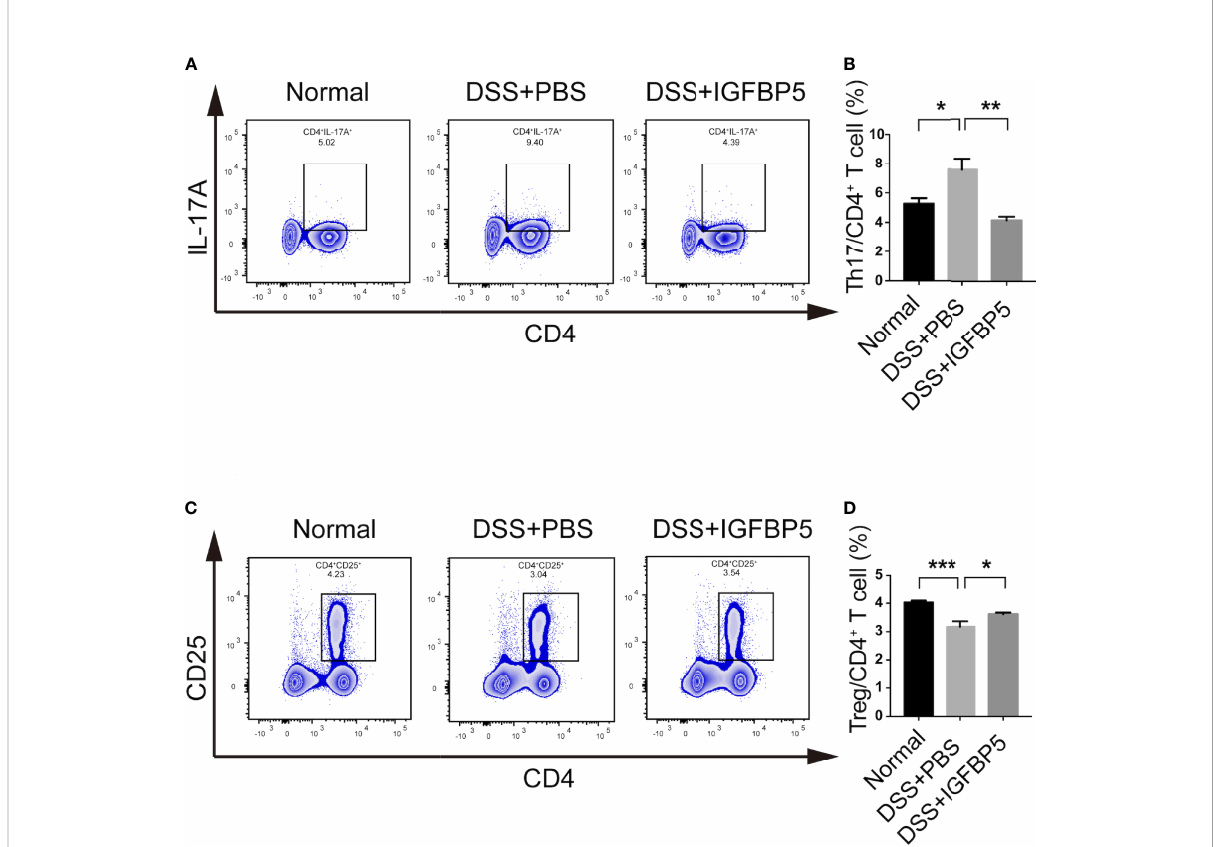
FIGURE 3 IGFBP5 maintained the balance of Th17/Treg cells in the mesenteric lymph nodes of mice. Cells were isolated from the mesenteric lymph nodes of mice with DSS-induced colitis and stained with fl uorochrome-conjugated antibodies against CD4, CD25 and IL-17A. (A) The number of Th17 were expressed as percentages of the CD4 + IL-17A + cell population. (B) Statistical analysis of Th17. (C) The number of Tregs were expressed as percentages of the CD4 + CD25 + cell population. (D) Statistical analysis of Tregs. The experiment was repeated three times independently. One- way ANOVA was used to determine statistical signi fi cance. The data are presented as the mean ± SEM (n=5). * p < 0.05, ** p < 0.01, *** p <